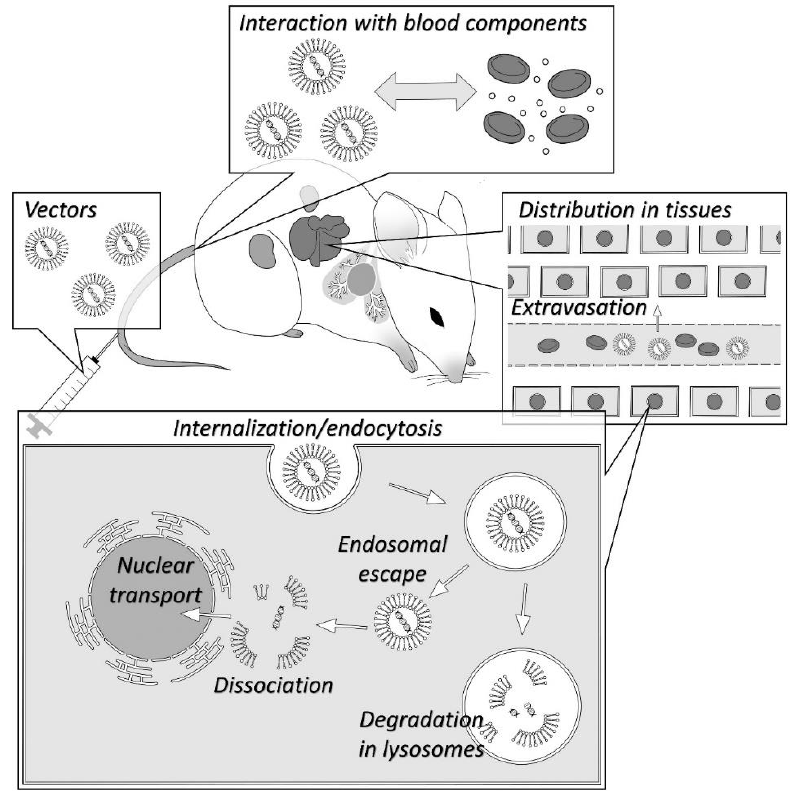
Figure 2. Schematic representation of the in vivo fate of vectors.